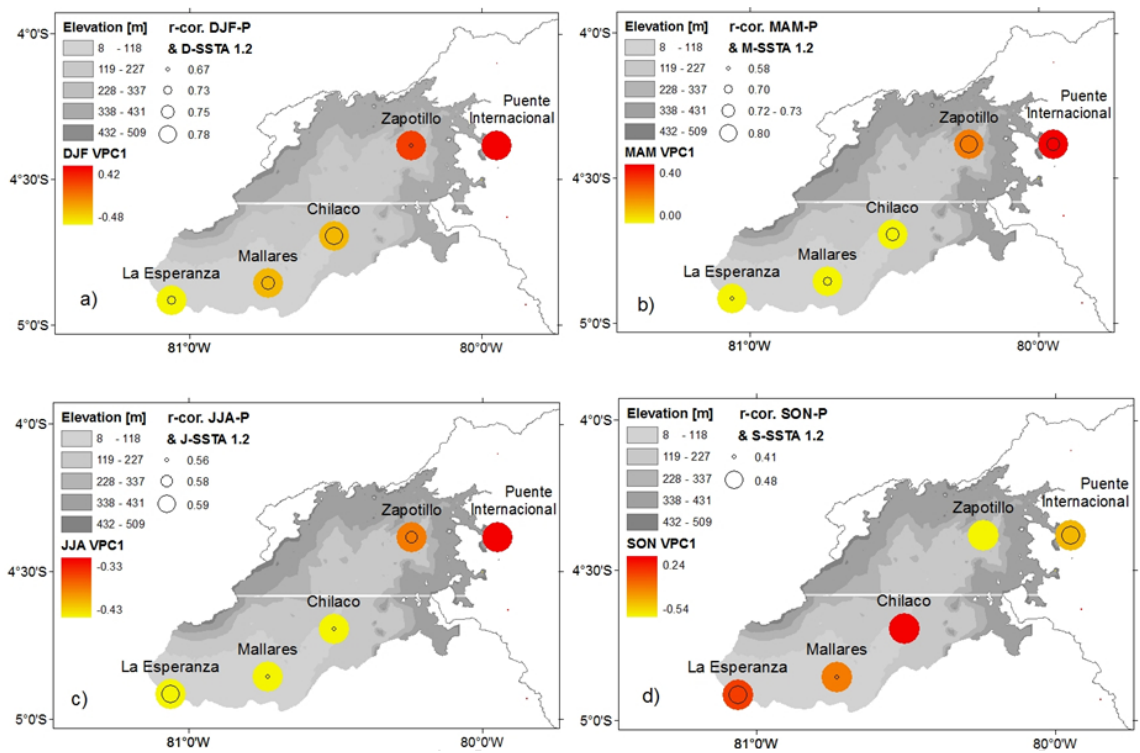
Fig. 2. Loading pattern of seasonal VPC (graded color: red-yellow), and, r-correlation plot of seasonal precipitation with one-month lagged SSTA 1.2 (graded dots) in the lower basin, for (a) VPC1 in DJF, (b) VPC1 in MAM, (c) VPC1 in JJA and (d) VPC1 in